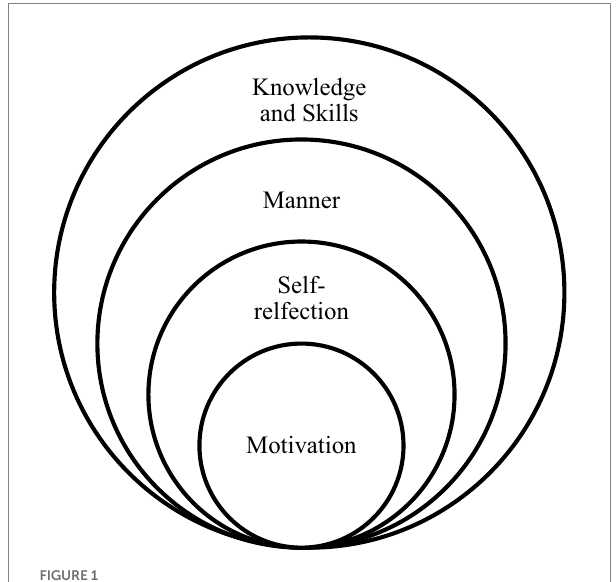
FIGURE 1 Four areas of teacher educators’